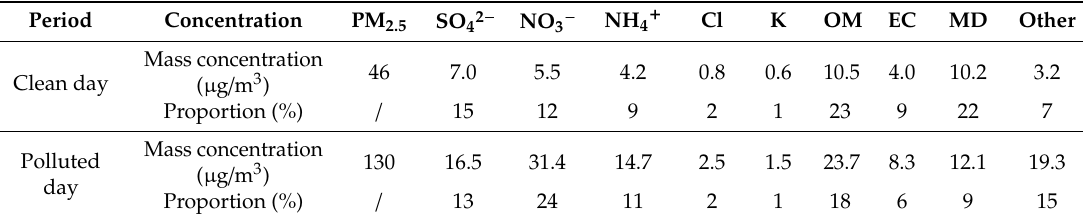
Table 2. Average concentration of major chemical components in PM 2.5 on clean days and polluted days.